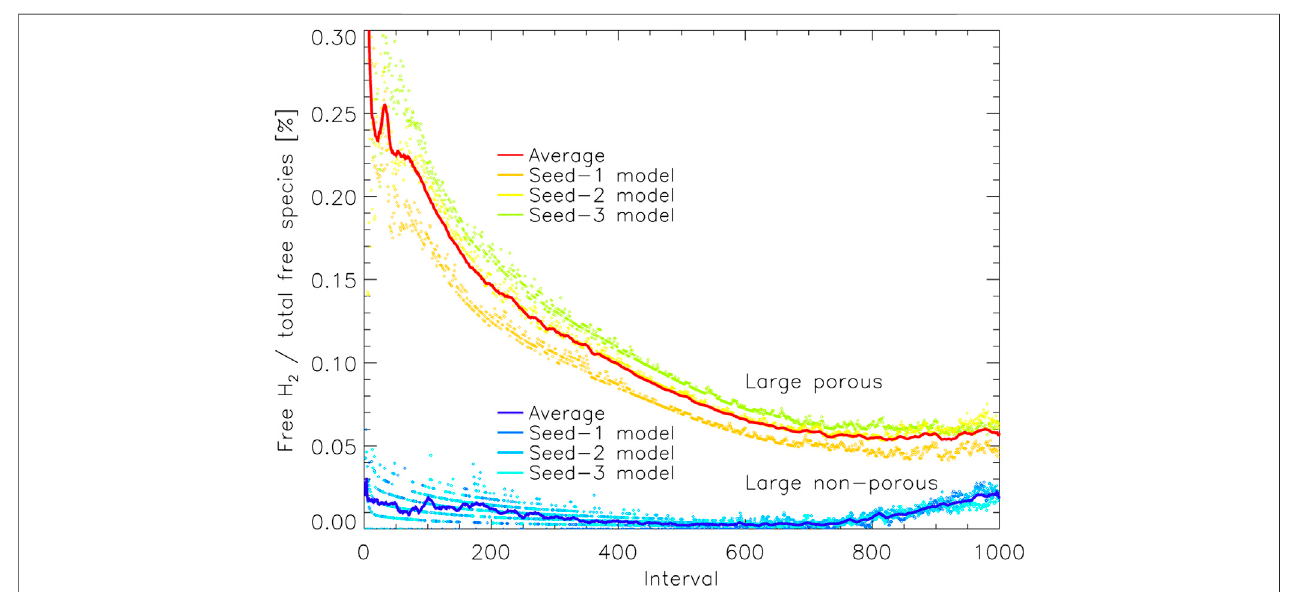
FIGURE8| Thepercentageoffreemolecularhydrogenpresentonthegrainasafunctionofallfreespecies,plottedvs.relativetimeintervalforthelargeporousand non-porous grain models. Free species are able to undergo surface diffusion and desorption, but may reside on enclosed surfaces within pores. The solid lines show a movingaverage(ofperiod10)overthethreerunsforeithergraintype,withthedatafromtheindividualrunsplottedasindividualpoints.Interval1,000correspondstothe end time of the models shown.